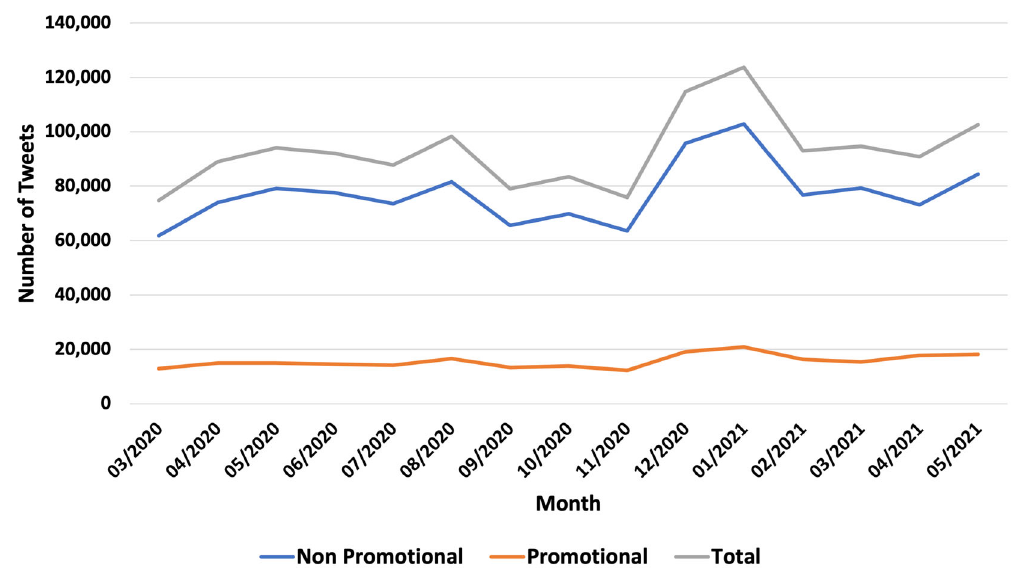
Figure 1. Number of tweets mentioning waterpipe over time.